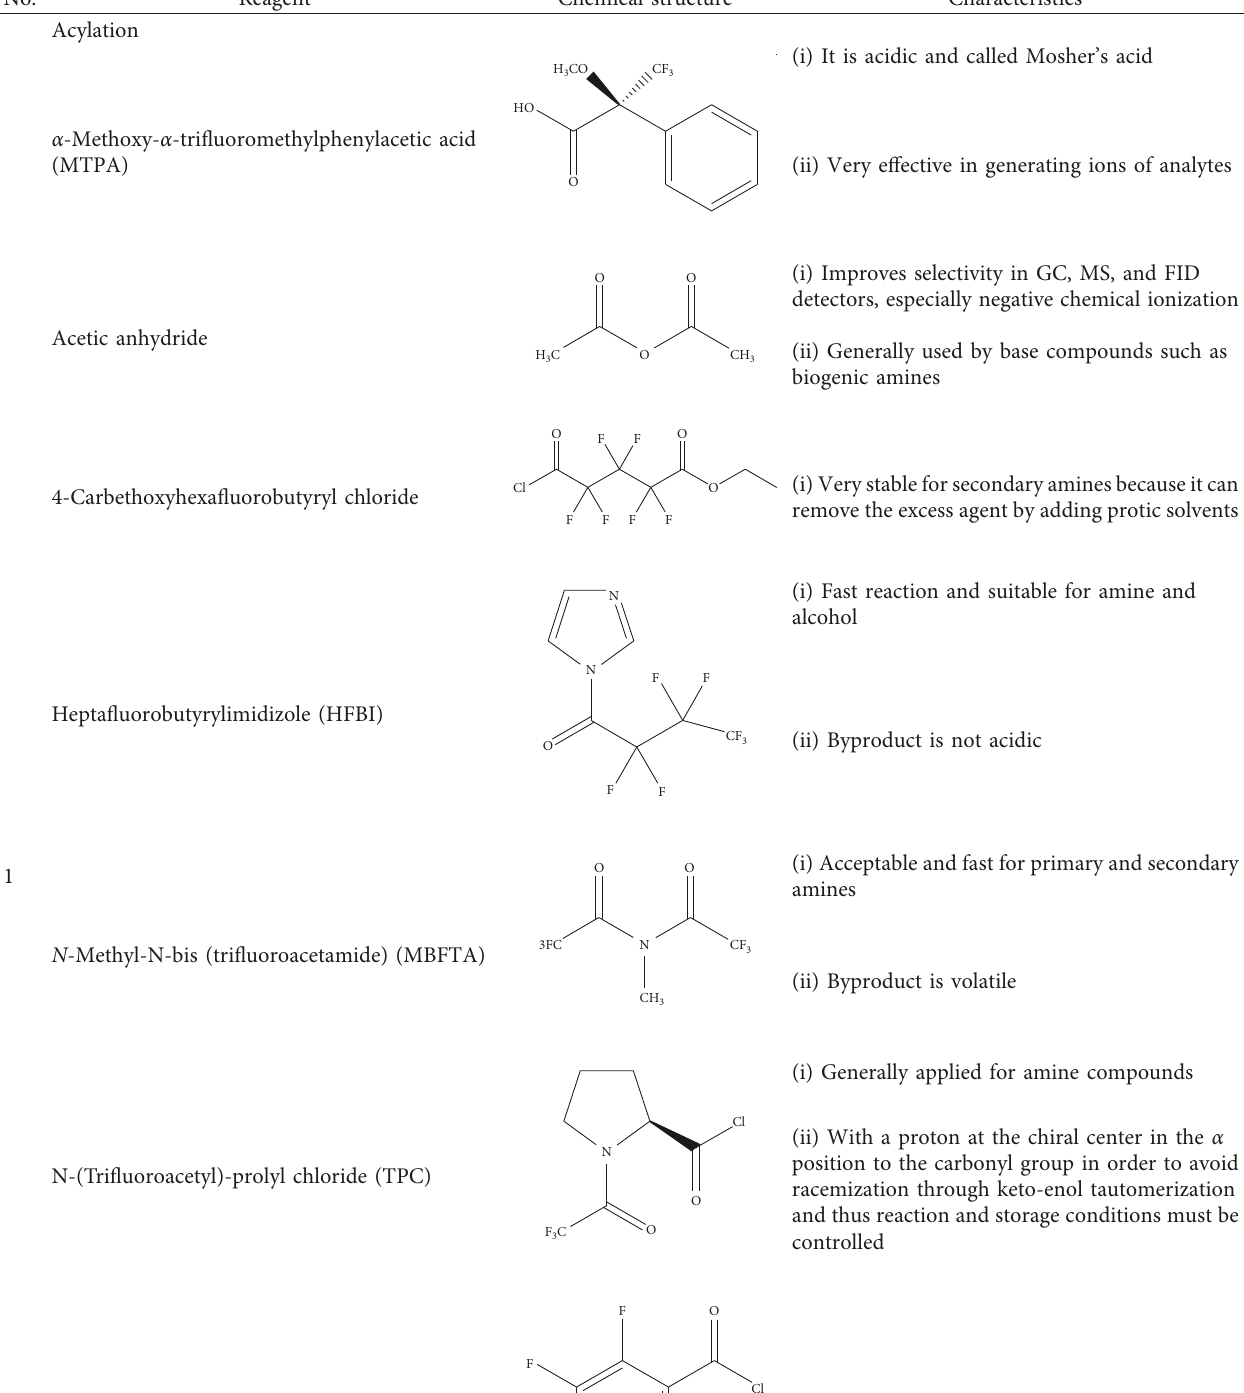
Table 3: Various derivatizing agents for gas chromatography purposes and their characteristics [65–67].